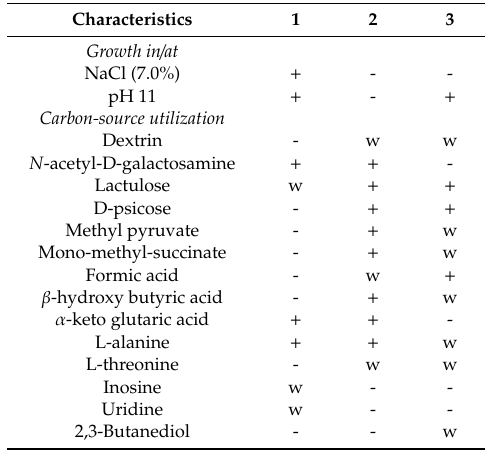
Table 1. The phenotypic characteristics of strain M15 T and closely related strains. 1, M15 T ;